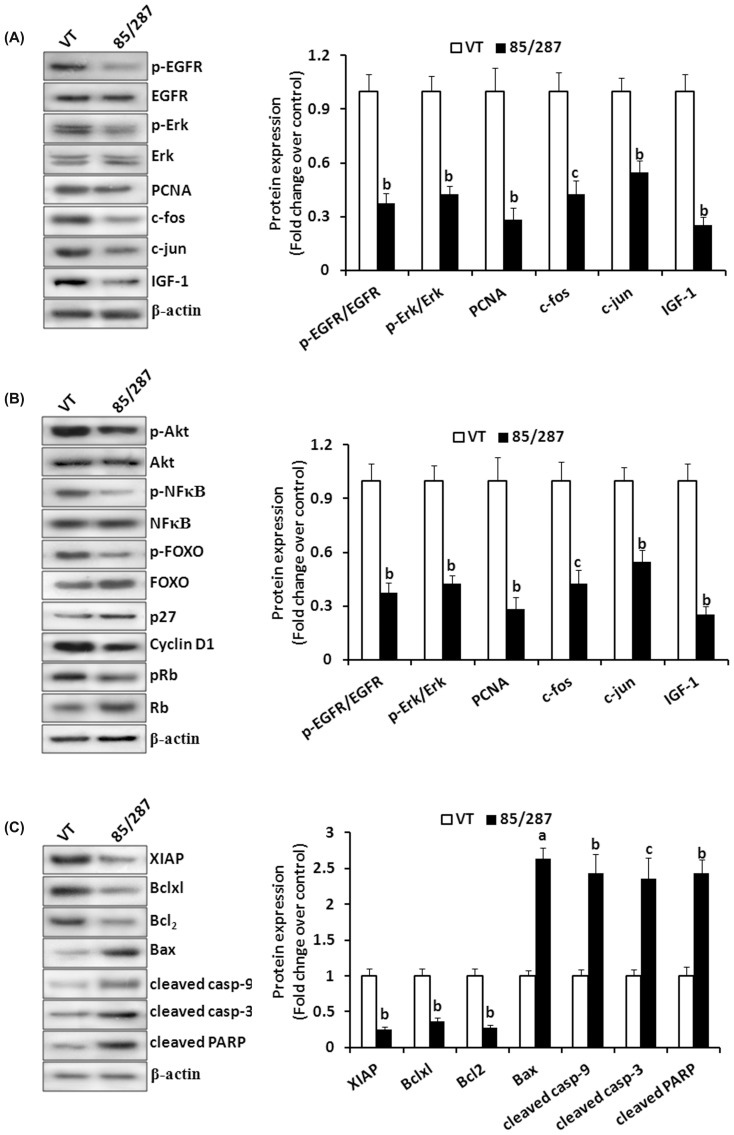
Effect of CDRI-85/287 on EGFR pathway in xenograft tissue.Western blot analysis to determine the effect of CDRI-85/287 on (A) activation of EGFR and MEK/Erk pathway, (B) activation of PI-3-K/Akt and expression of downstream effectors, and (C) the expression of pro- and anti- apoptotic proteins in vehicle and CDRI-85/287 treated xenograft tissue. 30 µg whole cell lysate in each lane was probed for the expression of different proteins using specific antibodies. β-actin was used as a control to correct for loading. Representative blots are shown in the left panel and densitometric quantitation of protein expression levels are shown as fold changes in the right panel. Results are expressed as mean ± SEM, n = 3. p values are a-p<0.001, b<0.01, c-p<0.05 and d-p>0.05 vs. control.